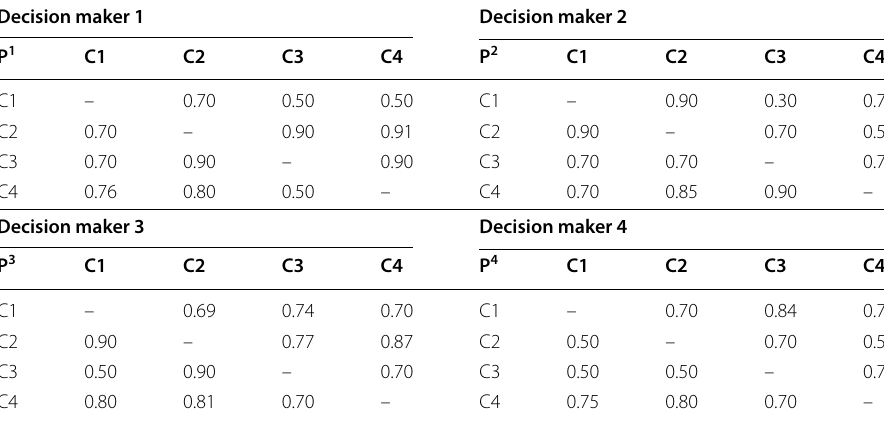
Table 15 Second-round fuzzy preferences for revenue sharing